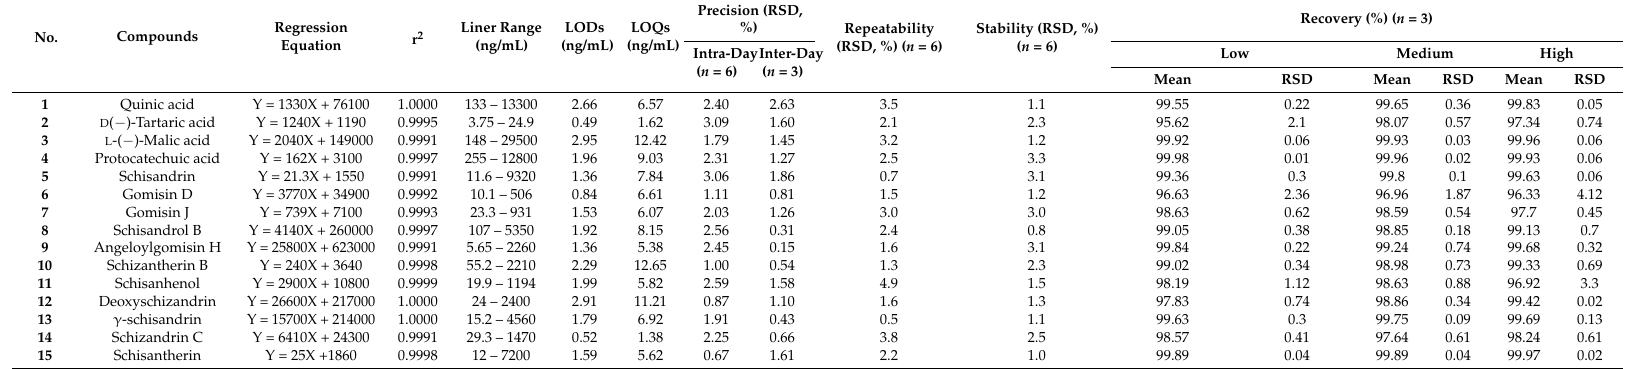
Table 2. Regression equation, limits of detection, limits of quantification, precision, repeatability, stability, and recovery of 30 investigated compounds.